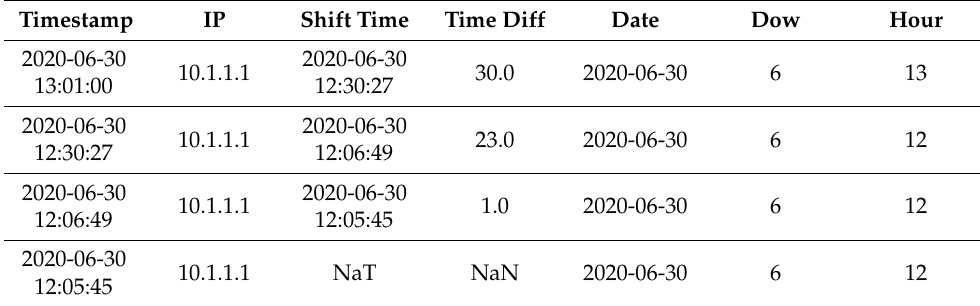
Table 5. Feature building based on